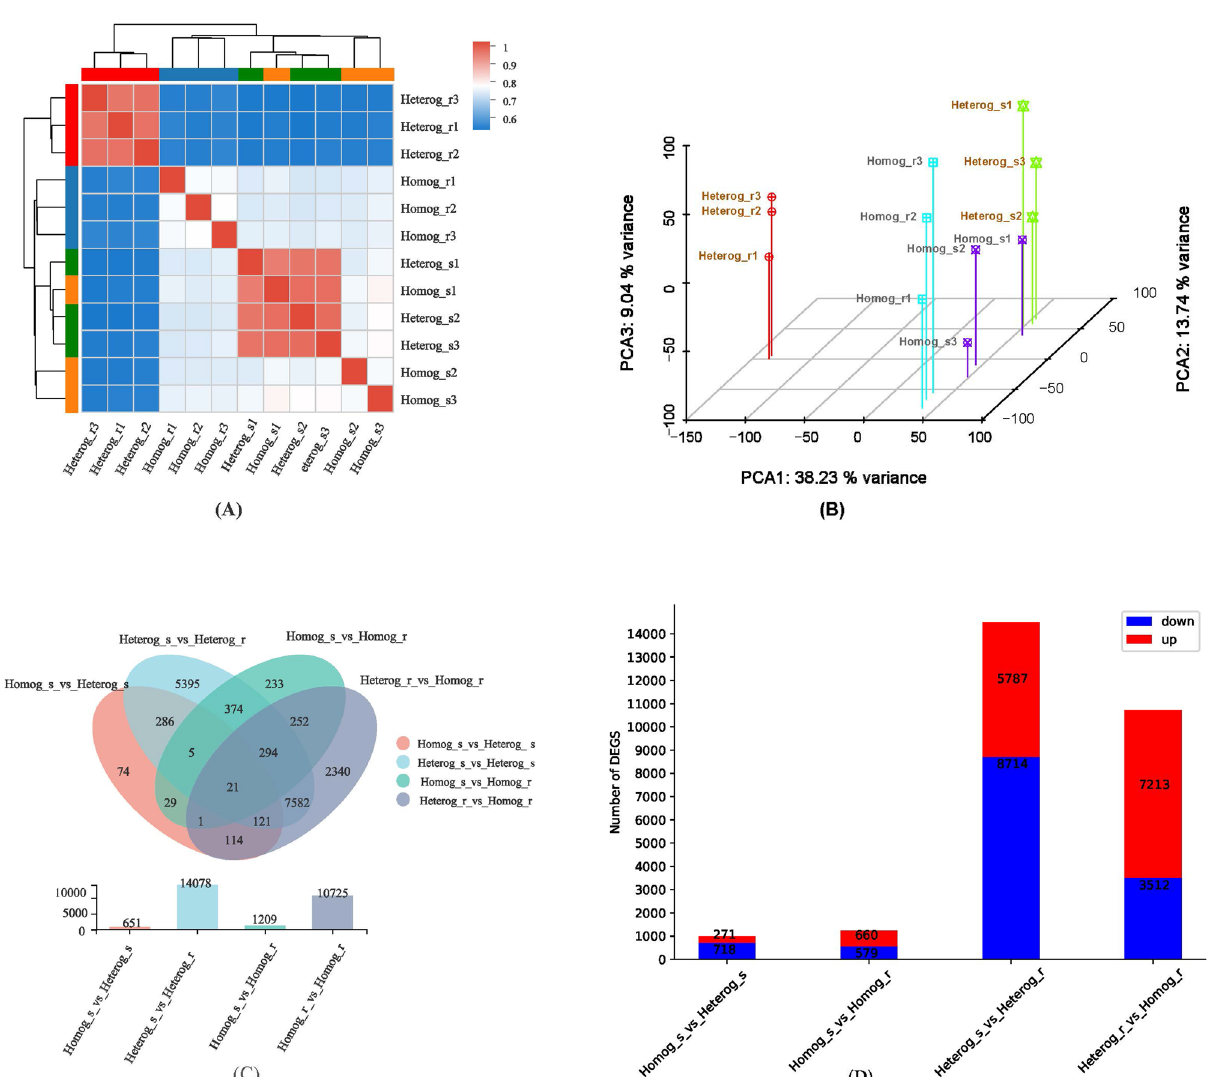
Figure 6. ( A ) Correlation of samples expression; ( B ) Principal component analysis between samples. ( C ) Number of up/down differential genes in different groups ( D ):Venen map of differentiallyexpressed genes between different